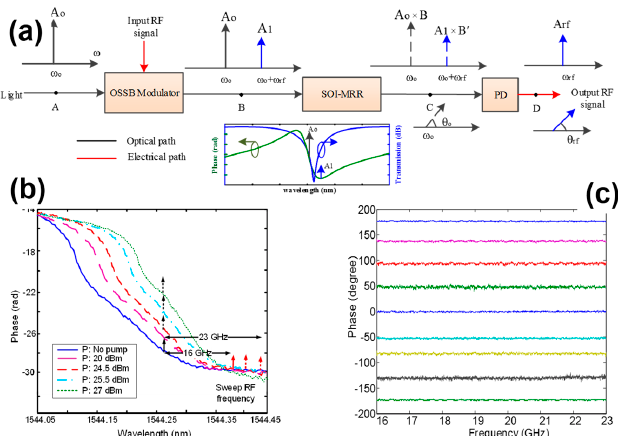
Figure 6. ( a ) Schematic of a microwave photonic phase shifter using an SOI MRR (silicon-on-insulator microring resonator) reported in [34]. OSSB: optical single-sideband, PD: photo-detector. Inset: the amplitude and phase responses of the SOI-MRR. ( b ) The phase response of the three cascaded microring resonators (MRRs) showing a net redshift of the phase response with the increase of the pumping power from 0 (no pump) to 27 dBm. ( c ) Measured phase shifts at di ff erent pumping power levels. Courtesy of Jianping Yao [34].